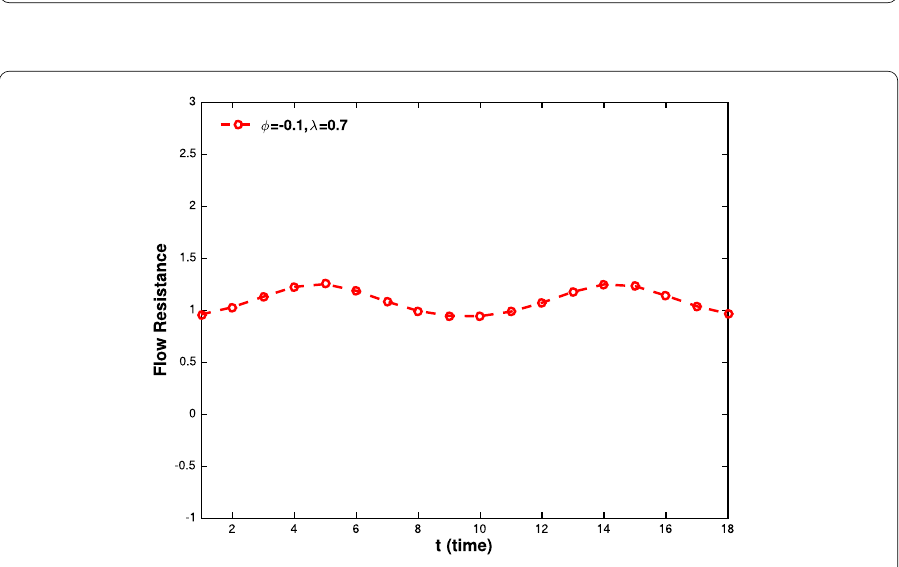
Figure 17 Flow resistance vs time for φ = –0.1 at z = 28, τ y = 0.4, K = 1.6, λ =